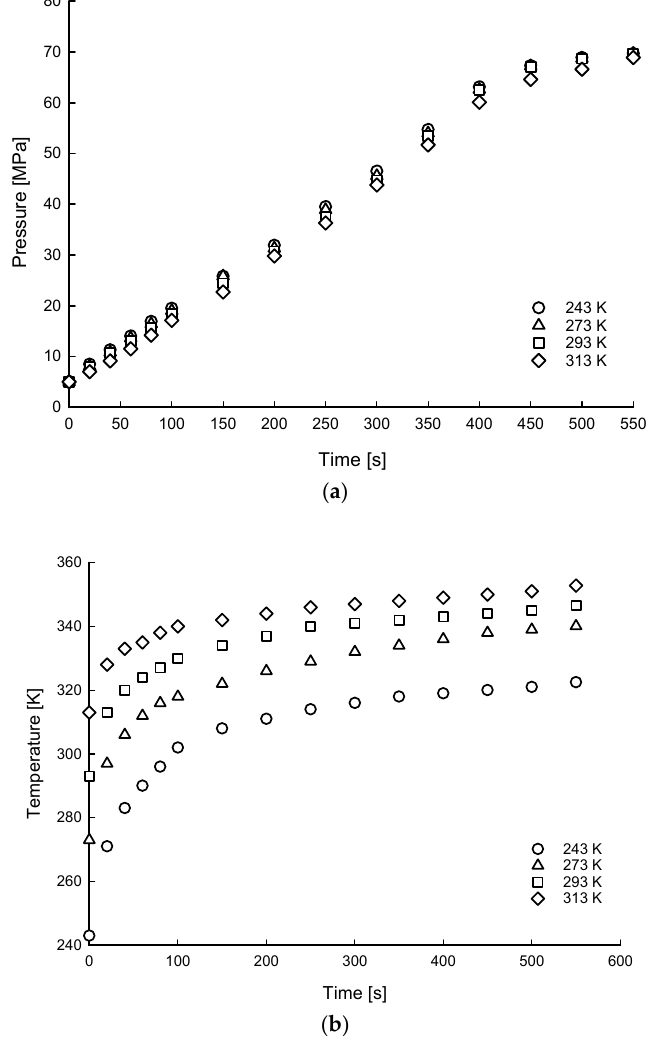
Figure 5. Time histories of hydrogen of average gas pressure ( a ) and temperature ( b ) distributions of filling process for 5 MPa SOC pressure condition under different ambient temperature conditions.